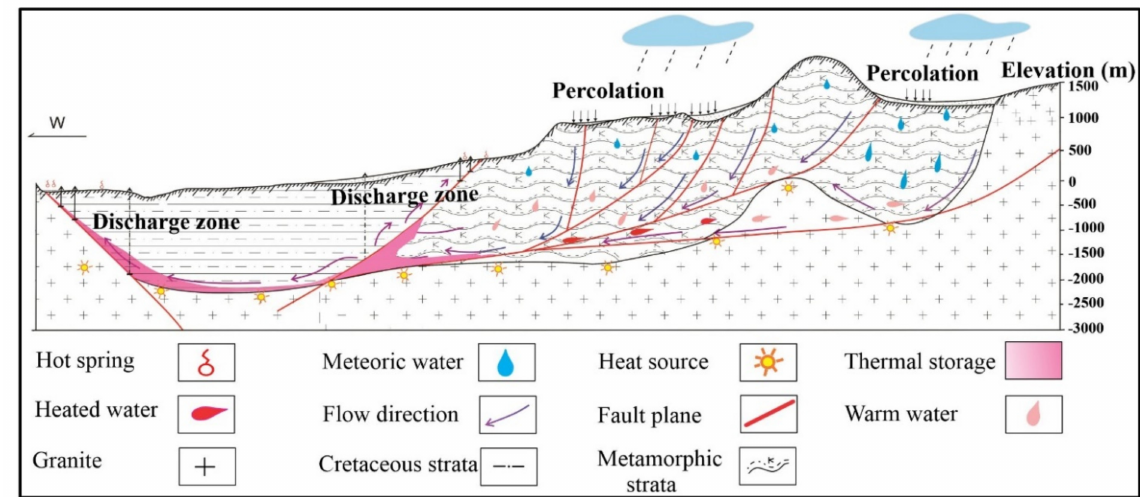
Figure 13. Conceptual genetic model of geothermal water circulation in Suichuan